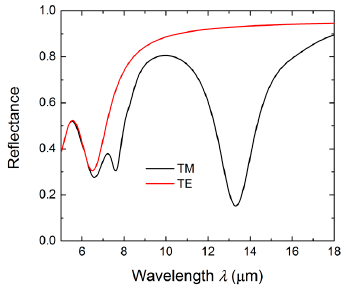
Figure 2. The simulated reflection spectra of the resonator under the transverse-magnetic (TM) and transverse-electric (TE) illumination.